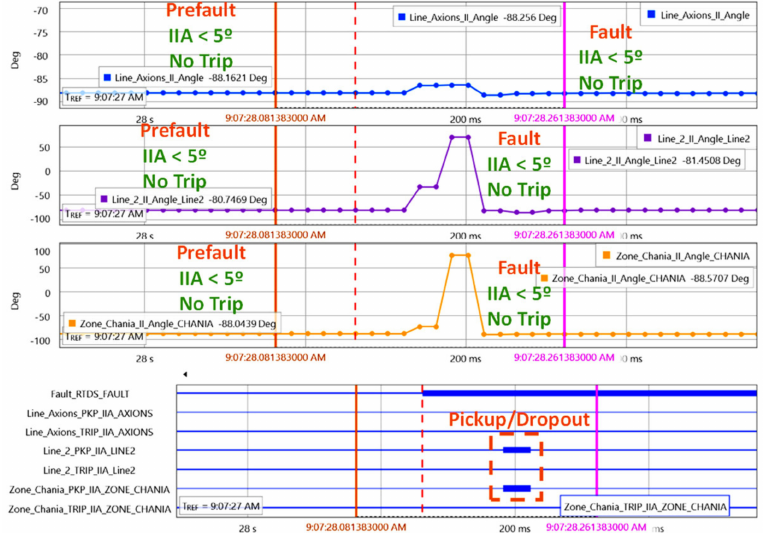
Figure 31. Line/Zone IIA behaviour; 3Ph external line/zone fault Side B; Rfault = 0.01 Ω ; two reactors